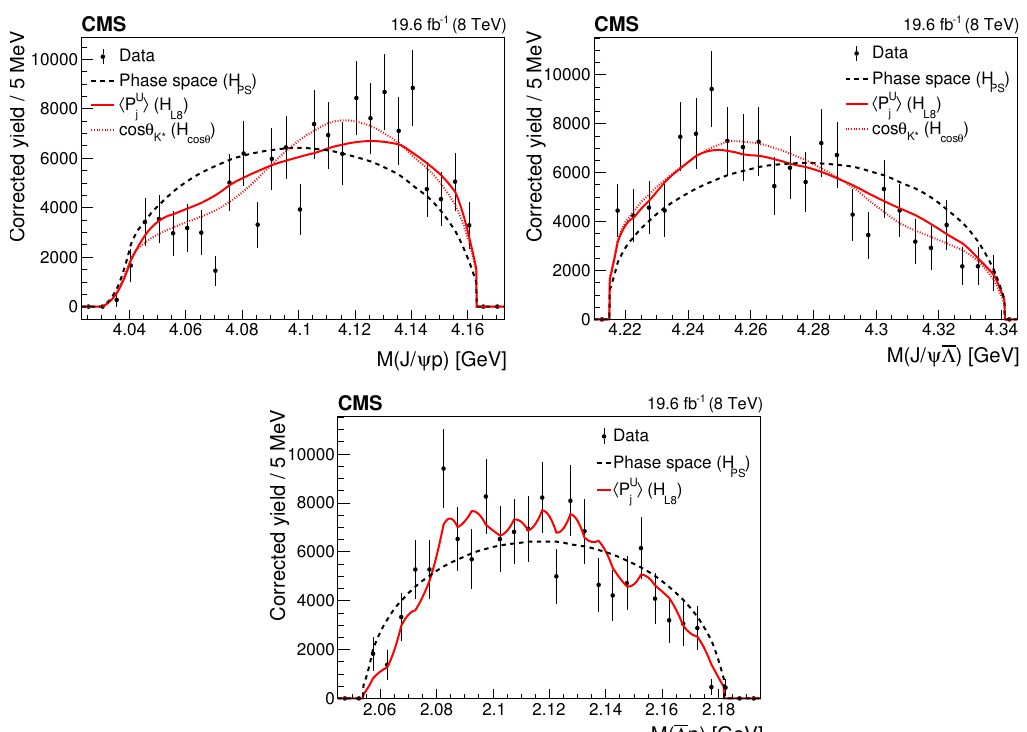
Figure 3 . The invariant mass distributions of the J = p (upper left), J = (cid:3) (upper right), and (cid:3)p (lower) systems from the B + ! J = (cid:3)p decay. The points show the e(cid:14)ciency-corrected, background-subtracted data; the vertical bars represent the statistical uncertainty. Superimposed curves are obtained from simulation: the dashed lines correspond to the pure phase space distri- bution ( H ); the solid curves represent the phase space distribution corrected for the (cid:3)p angular PS structure with the inclusion of the (cid:12)rst eight moments, corresponding to resonances decaying to the (cid:3)p system with maximum spin of 4 ( H ); the dotted curves show the phase space distribution L8 reweighted according to the cos (cid:18) distribution, which is de(cid:12)ned as the H hypothesis. The cos (cid:18) K (cid:3) mentioned curves are explained in section 8.1.